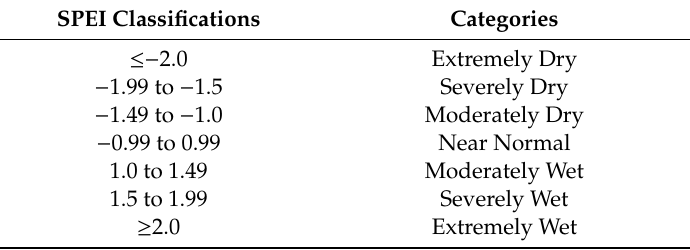
Figure 2. Methodological framework of the study conducted. Table 2. Drought classification according to Standard Precipitation Evaporation Index (SPEI)